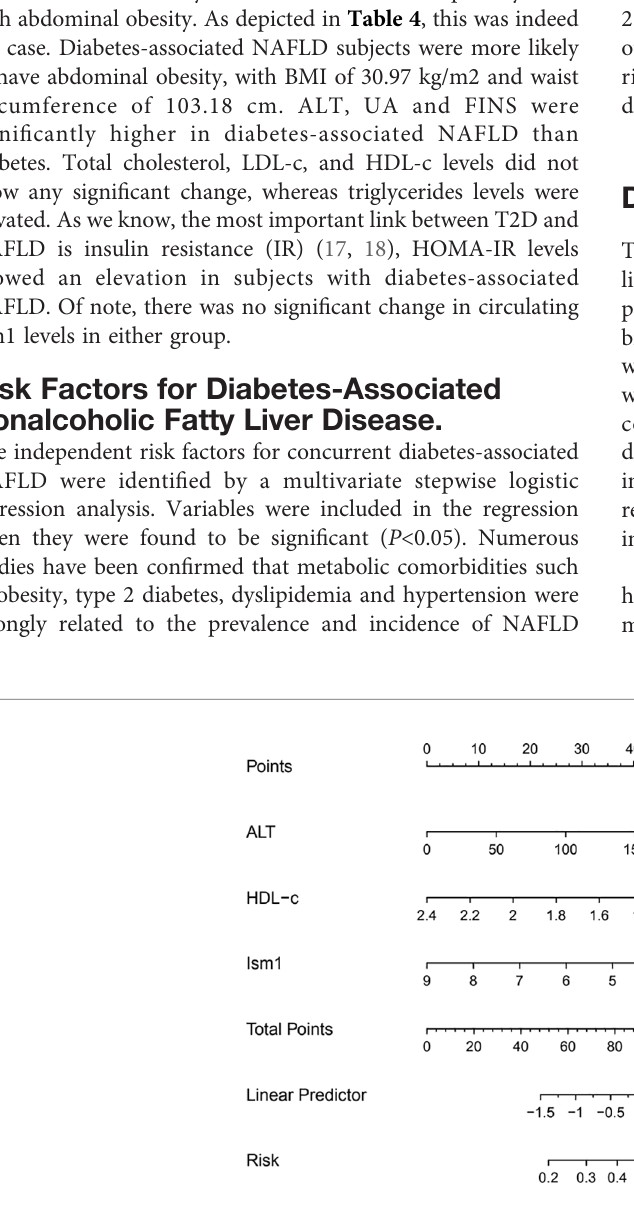
FIGURE 1 | Ism1 and the risk of type 2 diabetes.